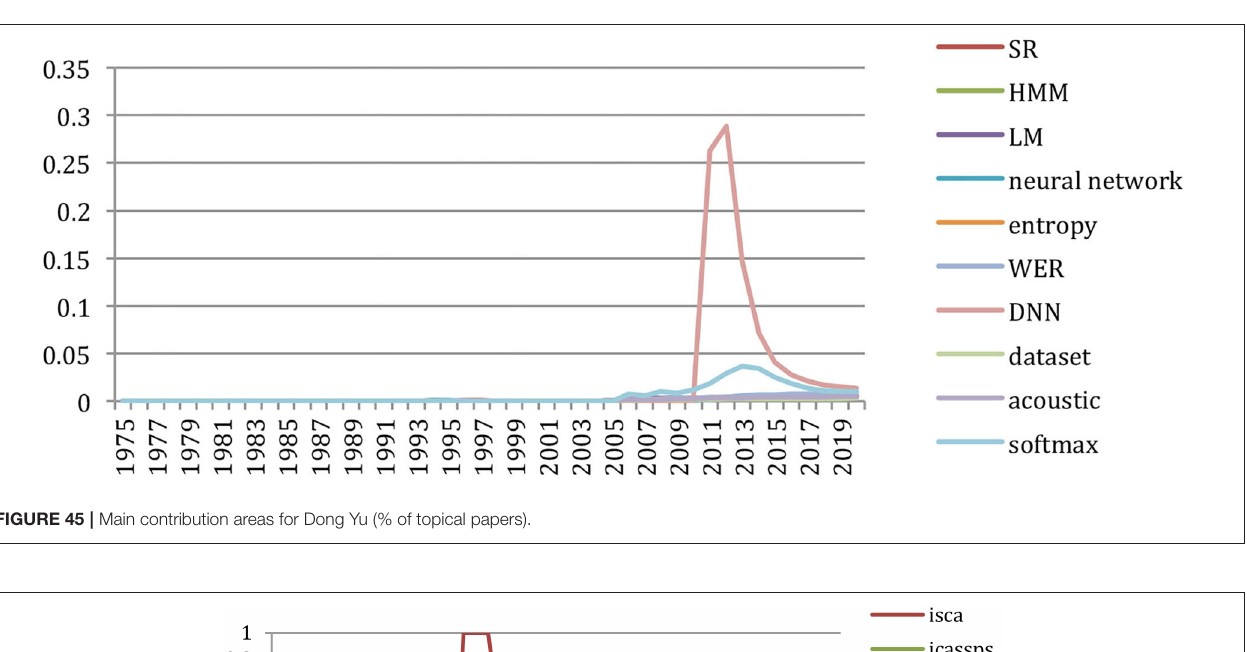
FIGURE 44 | Cumulative authors’ contributions to the study of DNN in speech and NLP (% of topical papers).